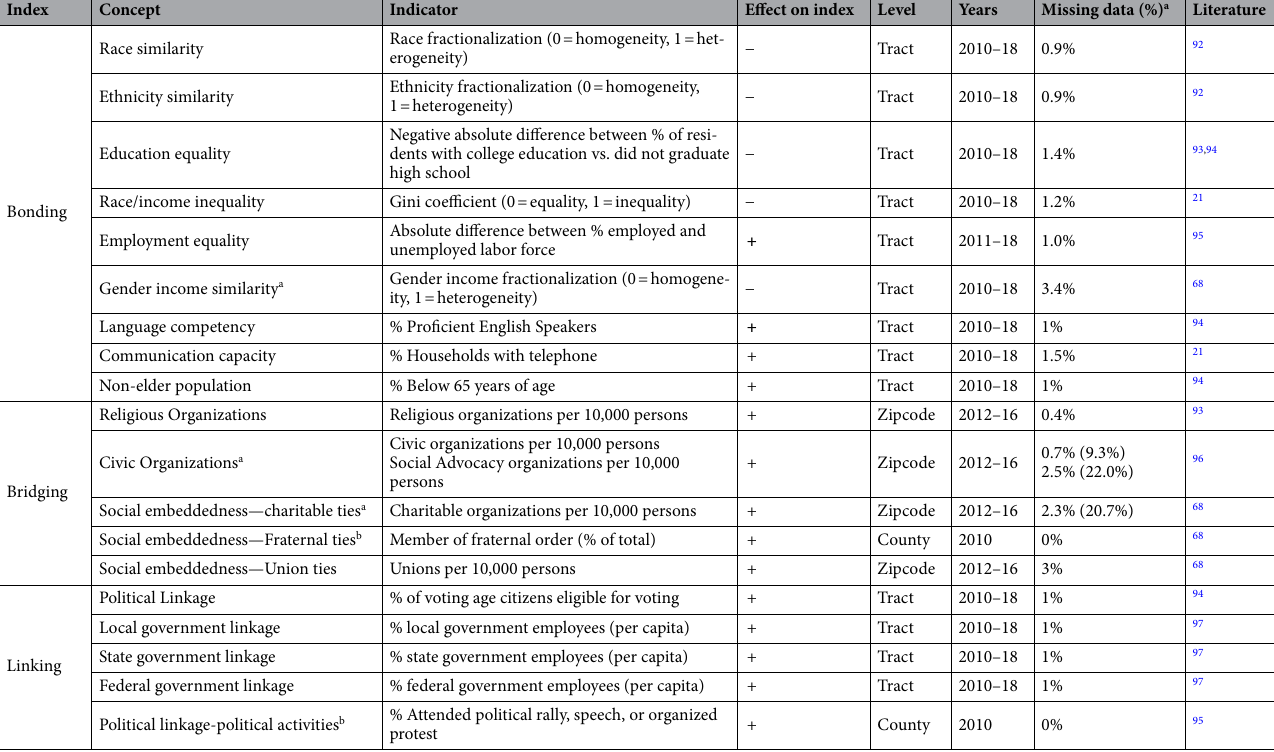
Table 1. Indicators for census-tract level social capital indices. a Filled in missing census tract values with average value from census tracts in that county. Missing data tally reflects after imputing county median for specially marked zipcode bridging social capital measures. b Used county level measure, because comparable measures were unavailable at local